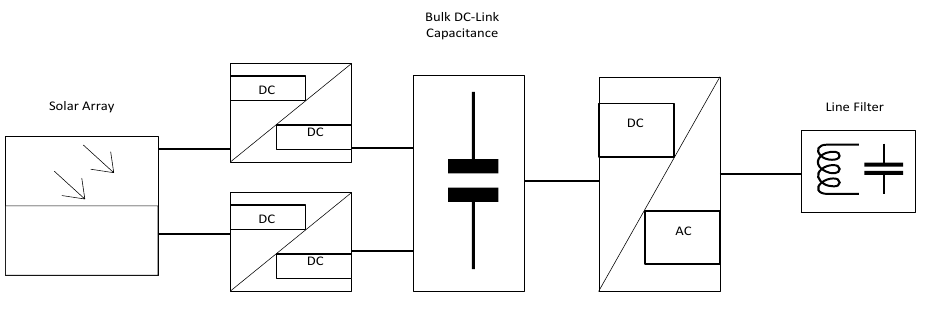
Figure 8. Schematic of one string PV system inverter.